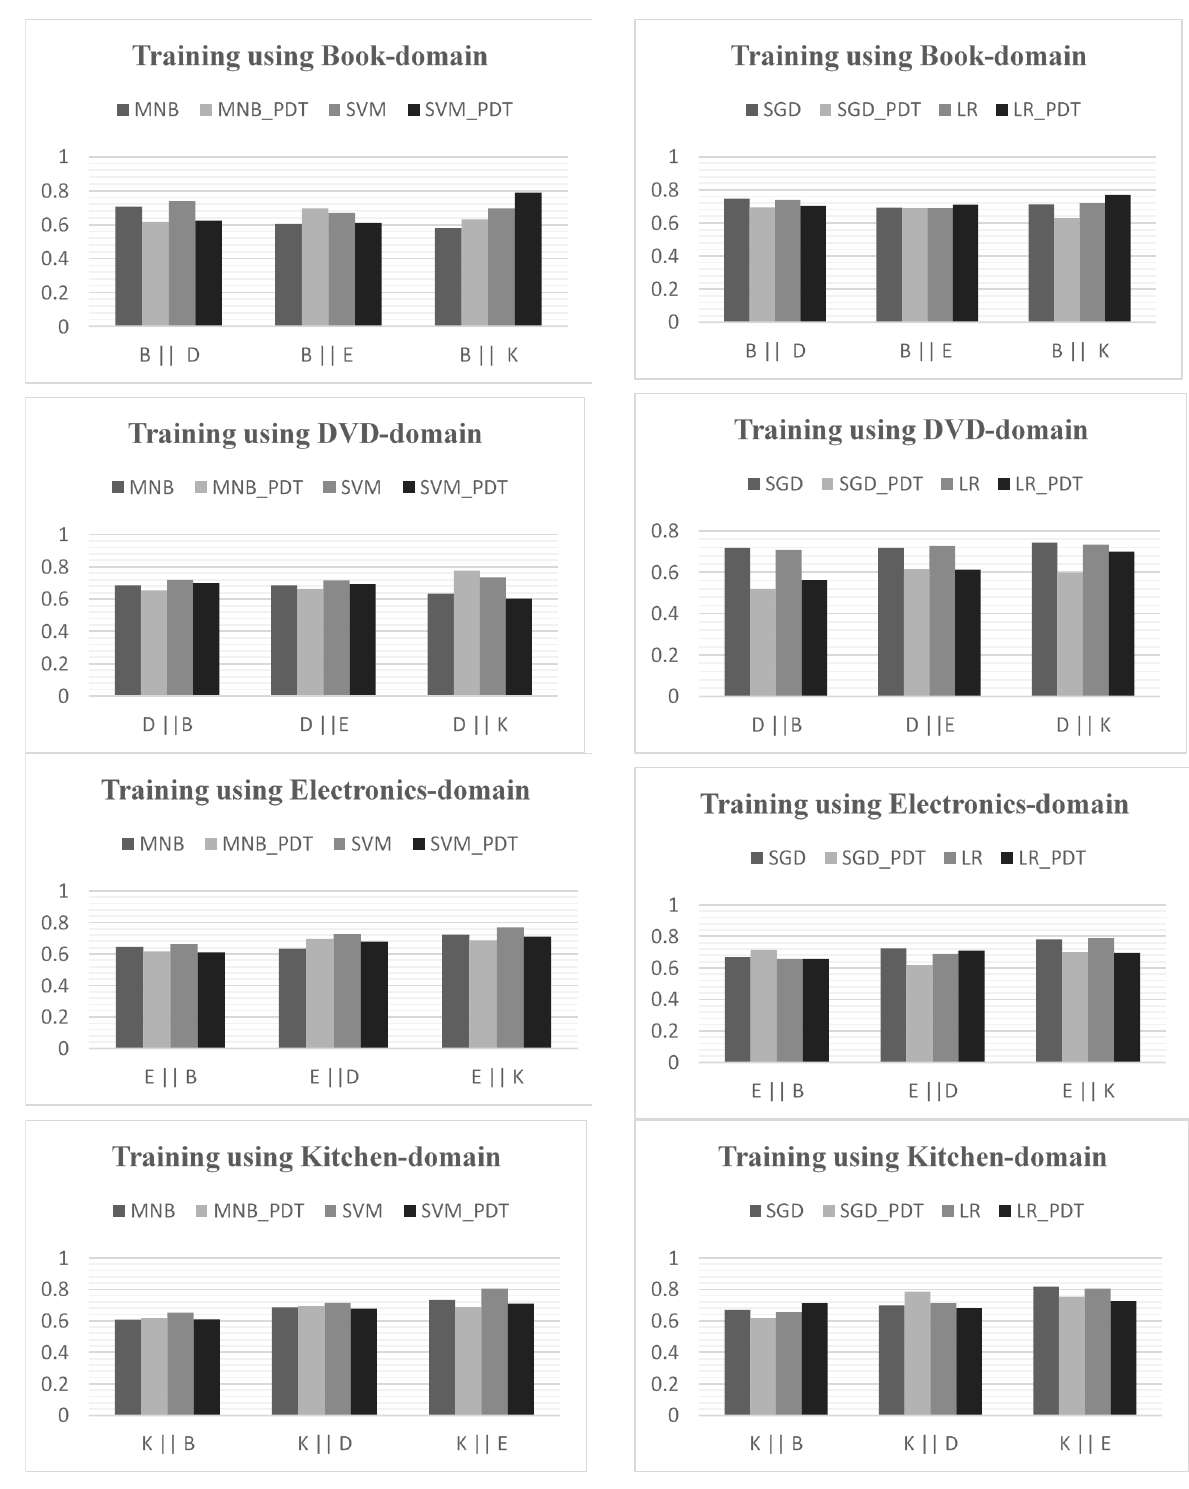
Figure 4. Comparison of PDT+ classification to the traditional learning process of